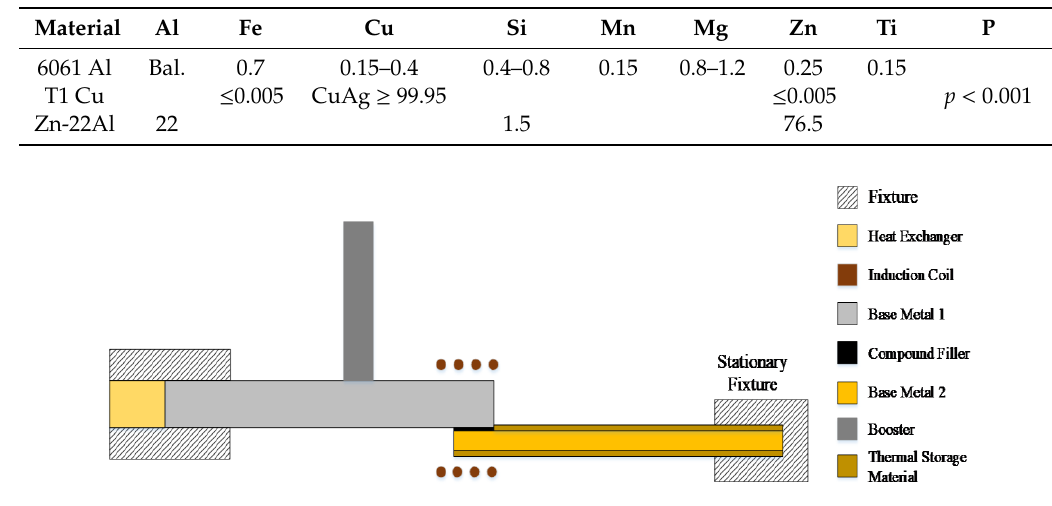
Figure 1. Schematic representation of bonding process for vibration brazing.